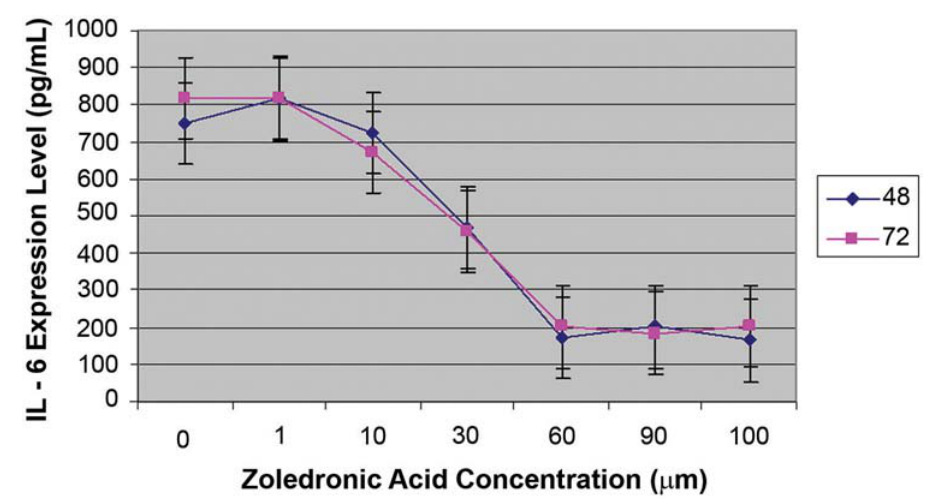
Figure 4 – (cid:3)(cid:40)(cid:73)(cid:73)(cid:72)(cid:70)(cid:87)(cid:3)(cid:82)(cid:73)(cid:3)(cid:93)(cid:82)(cid:79)(cid:72)(cid:71)(cid:85)(cid:82)(cid:81)(cid:76)(cid:70)(cid:3)(cid:68)(cid:70)(cid:76)(cid:71)(cid:3)(cid:87)(cid:85)(cid:72)(cid:68)(cid:87)(cid:80)(cid:72)(cid:81)(cid:87)(cid:3)(cid:82)(cid:81)(cid:3)(cid:44)(cid:47)(cid:16)(cid:25)(cid:3)(cid:86)(cid:72)(cid:70)(cid:85)(cid:72)(cid:87)(cid:76)(cid:82)(cid:81)(cid:3)(cid:76)(cid:81)(cid:3)(cid:39)(cid:56)(cid:20)(cid:23)(cid:24)(cid:3)(cid:70)(cid:72)(cid:79)(cid:79)(cid:3)(cid:79)(cid:76)(cid:81)(cid:72)(cid:17)(cid:3)(cid:20)(cid:19) (cid:24) viable cell/well was treated with increasing concentrations of zoledronic acid. IL-6 levels were measured after 48 and 72 hours by ELISA in the supernatants of zoledronic acid